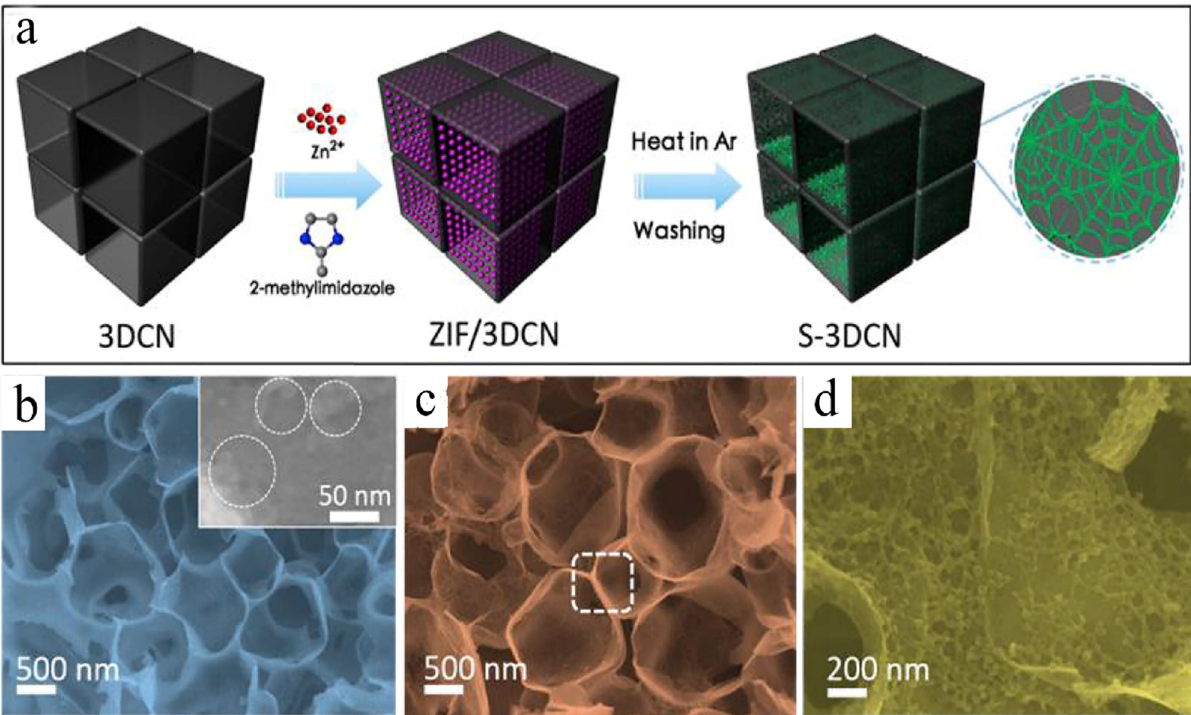
Figure 3: Product process and SEM image of S - 3DCN ( 71 ) . ( a ) Schematic diagram of the S - 3DCN synthesis process. ( b ) SEM image of ZIF/ 3DCN and an enlarged image of ZIF particles on the carbon wall. ( c and d ) SEM image of S - 3DCN. Copyright 2019,